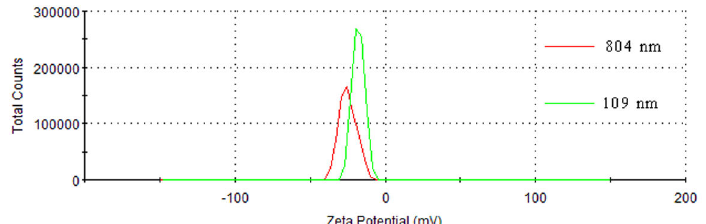
Figure 8. Zeta potential distribution of DPG particles with different sizes.